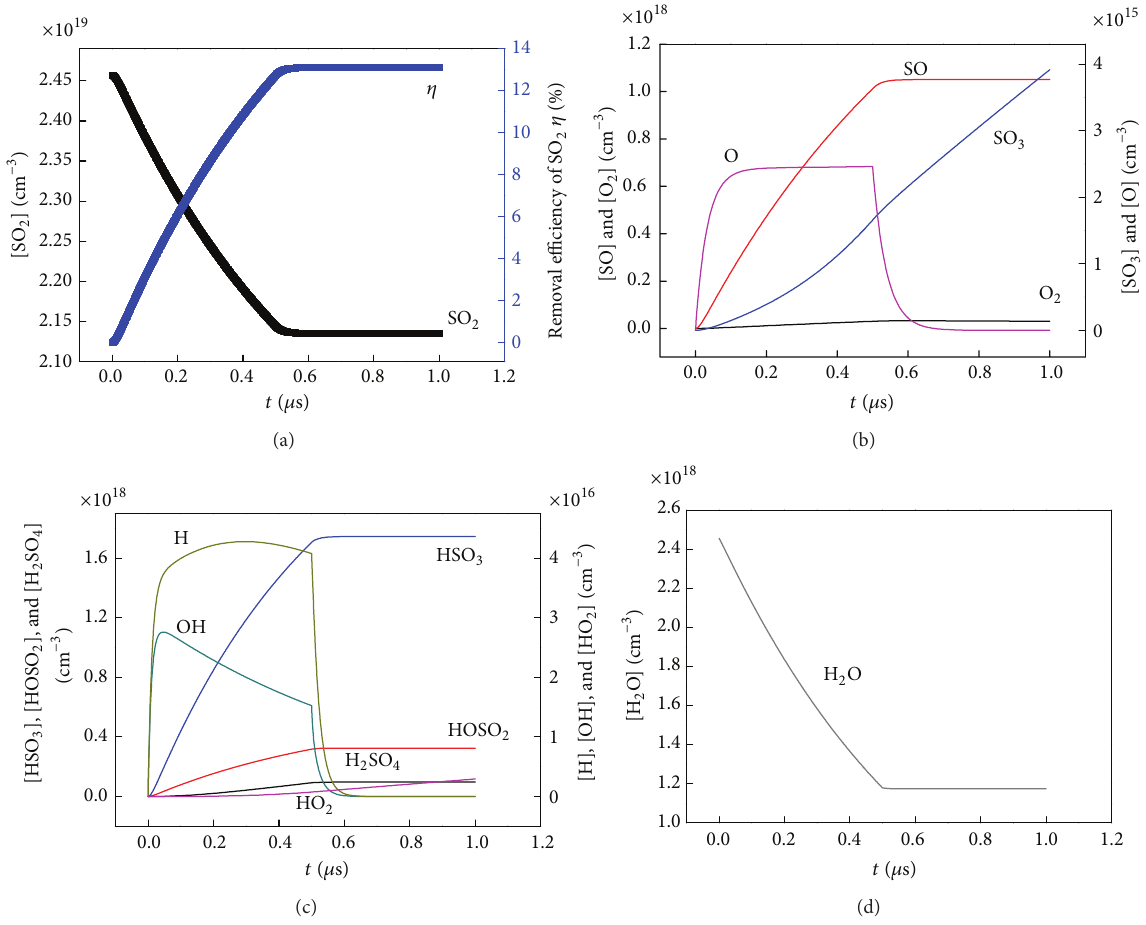
Figure 7: Under H 2 O/SO 2 initial ratio of 0.1: 1 and discharge pulse duration of 0.5 𝜇 s, time-resolved evolution of (a) SO 2 concentration and the corresponding removal efficiency, (b) SO, O 2 , SO 3 , and O concentration, (c) HSO 3 , HOSO 2 , H 2 SO 4 , H, OH, and HO 2 concentration, and (d) H 2 O